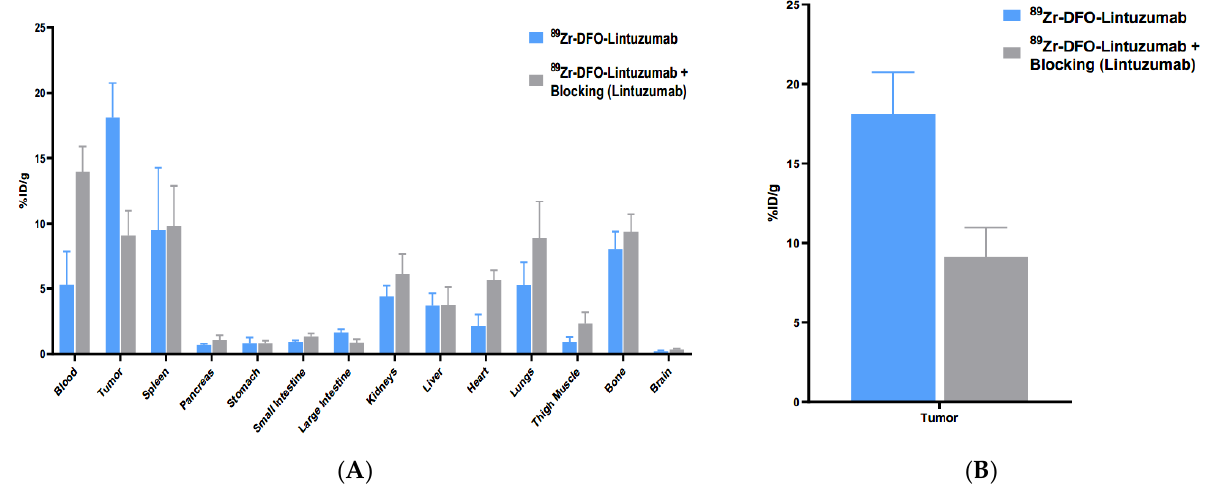
Figure 3. 89 Zr-lintuzumab biodistribution in mice bearing AML-OCI3 tumors. ( A ) Ex vivo biodistri- bution study of 89 Zr-DFO-Lintuzumab in mice bearing OCI-AML-3. Mice were inoculated with 2 × 10 6 OCI-AML3 cells in the right flank. Tumors were allowed to grow for 12 days prior to lintuzumab injection. To demonstrate in vivo target specificity, a cohort of mice ( n = 4) was blocked with 0.5 mg cold Lintuzumab on Day 0. 5.55 MBq 89 Zr-DFO-Lintuzumab was administered to both cohorts of mice (blocked and non-blocked; n = 4 for each) on Day 1. All mice were subsequently sacrificed on Day 8 post-administration; tumors and several tissues were harvested, weighted, and measured for radioactivity. ( B ) High specific uptake of 89 Zr-DFO-Lintuzumab in OCI-AML-3 tumors is observed in the cohort of mice without Lintuzumab